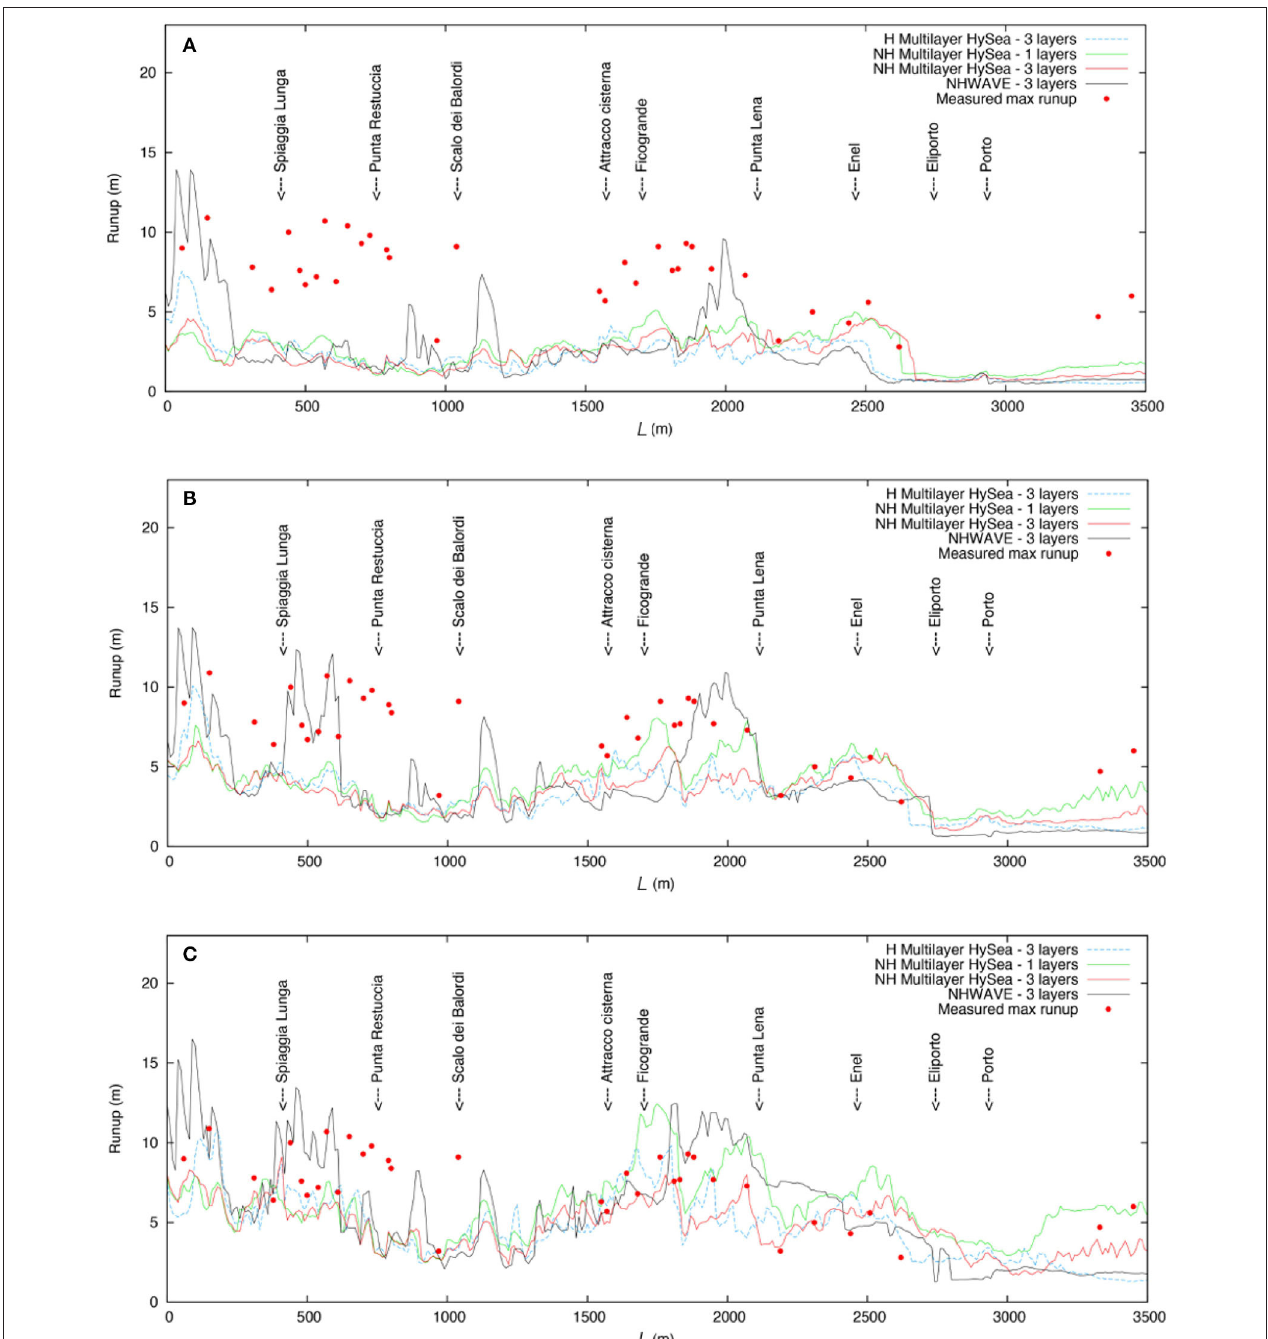
FIGURE 7 | Tsunami maximum runup along the stretch of coastline represented by the white solid line in Figure 8 , obtained with different wave models with a RL model (A) V = 7.1 × 10 6 m 3 , (B) V = 11.8 × 10 6 m 3 , and (C) V = 17.6 × 10 6 m 3 .